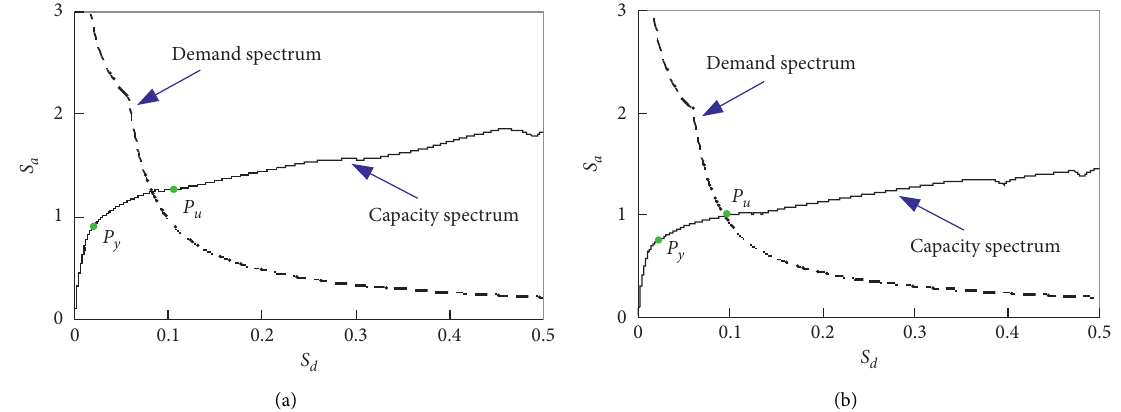
Figure 12: Check of design scheme: (a) preliminary scheme and (b) new scheme.